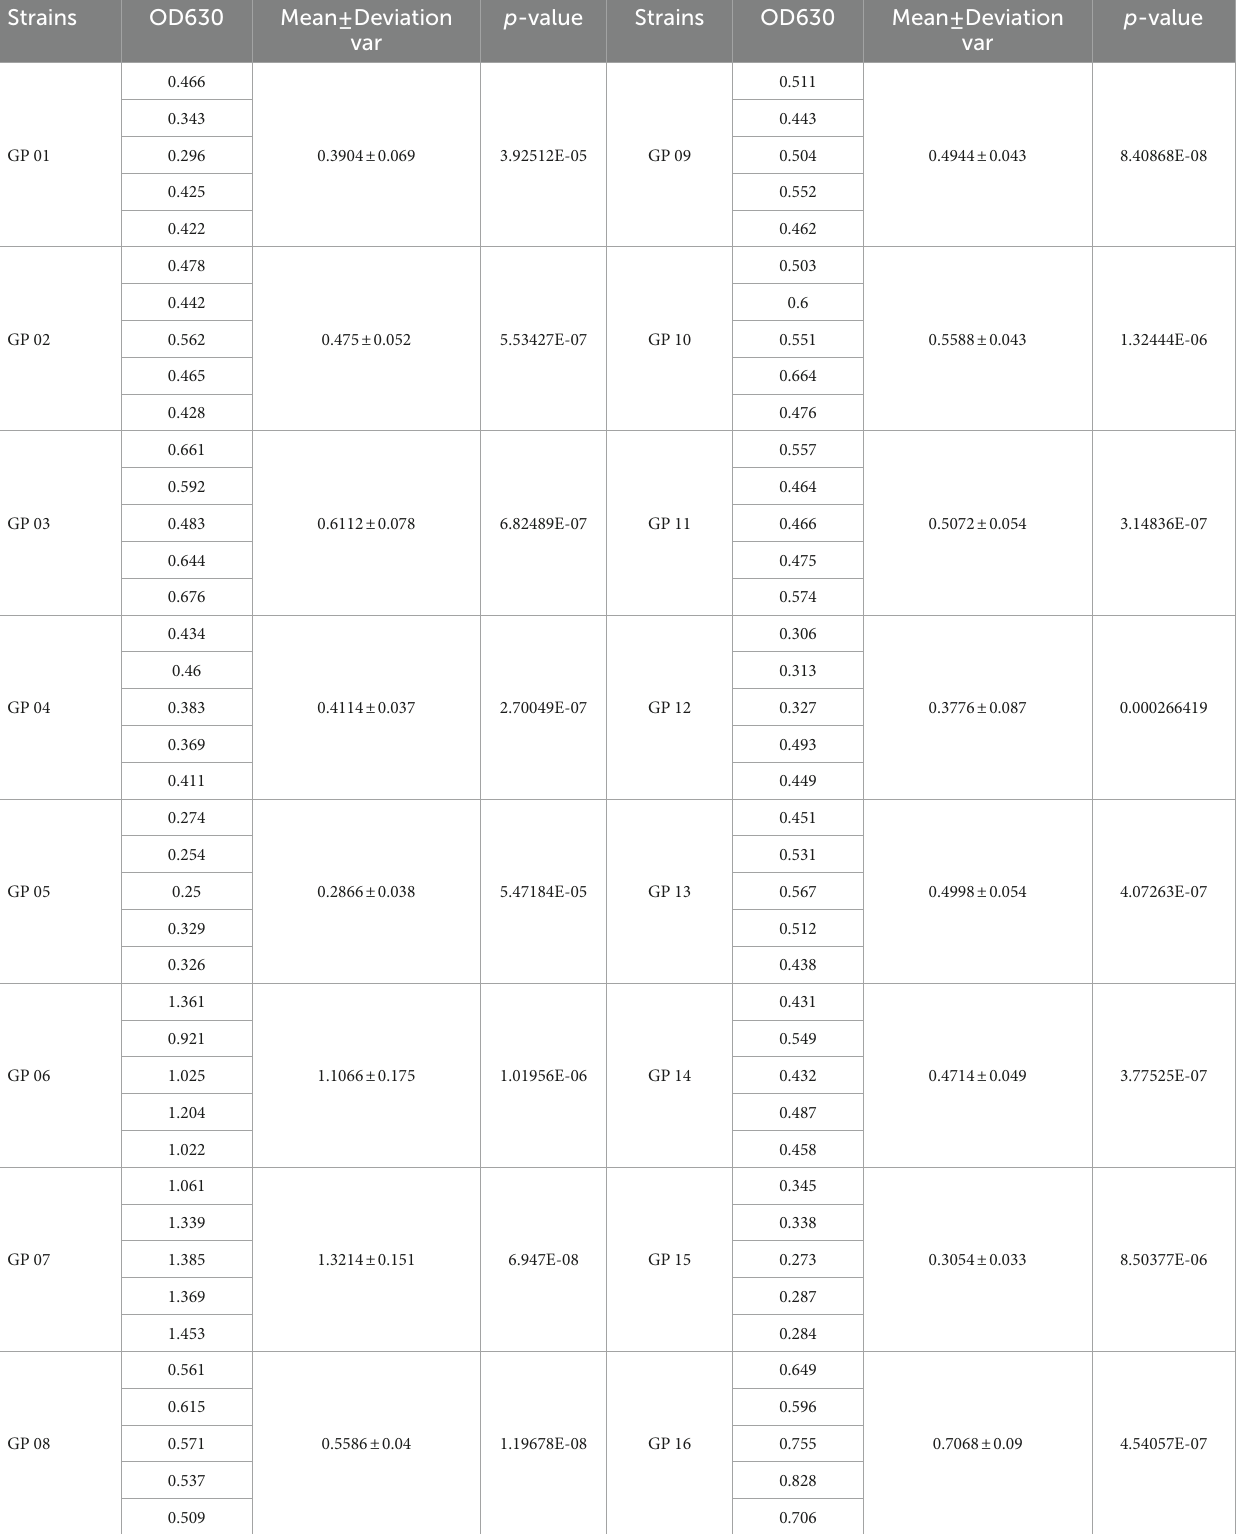
TABLE 9 Comparison of biofilm forming ability of 16 G. parasuis strains. Strains OD630 Mean ± Deviation